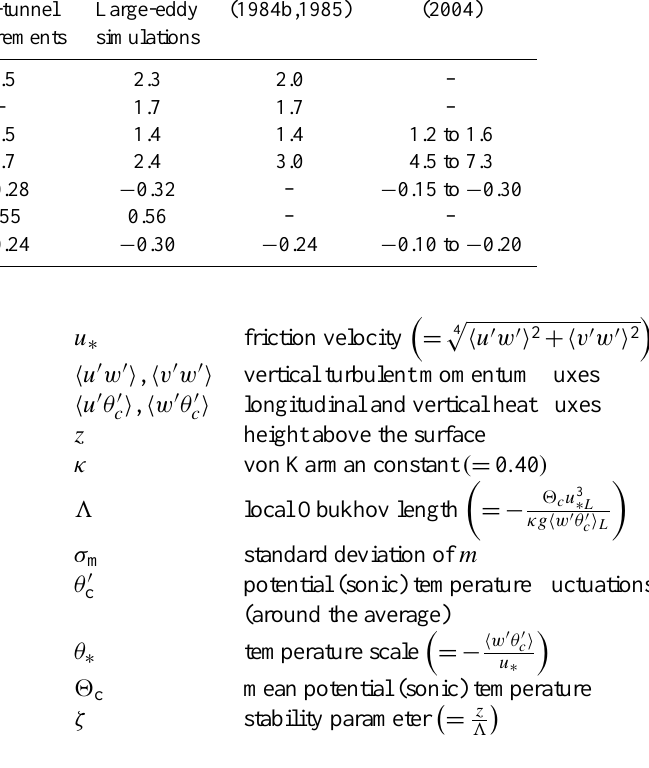
Table 3. The z-less values of turbulence statistics. Turbulence ISCAT 2000